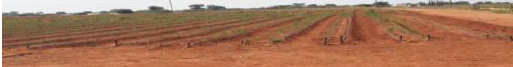
Figure 6: Horticultural farm in Dikabeya - The top soil is susceptible to soil erosion by water as a result of artificial rills and gullies